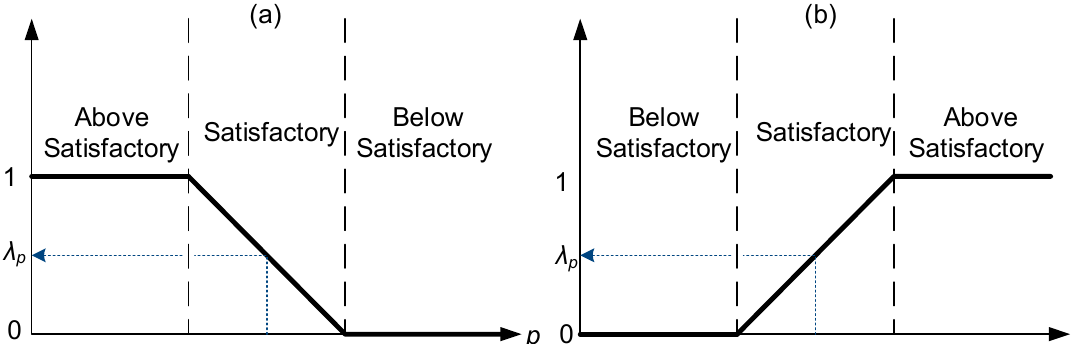
Figure 2. Degree of satisfaction for ( a ) property to be minimised and ( b ) property to be maximised.